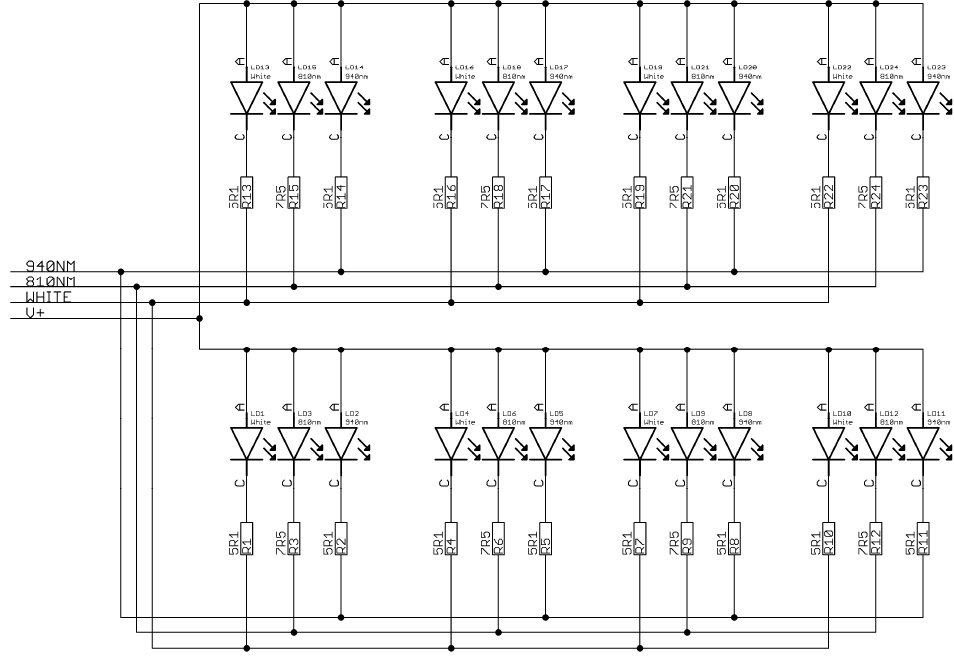
Figure A6. LEDs array. One LED per spectral band.